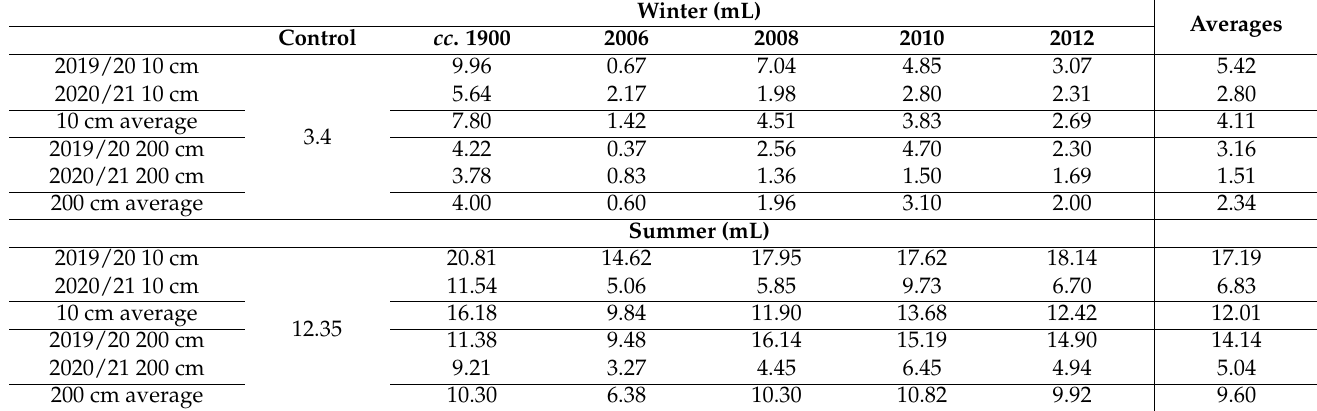
Table 2. Average infiltration for 10 and 200 cm proximities throughout both winter and summer sample